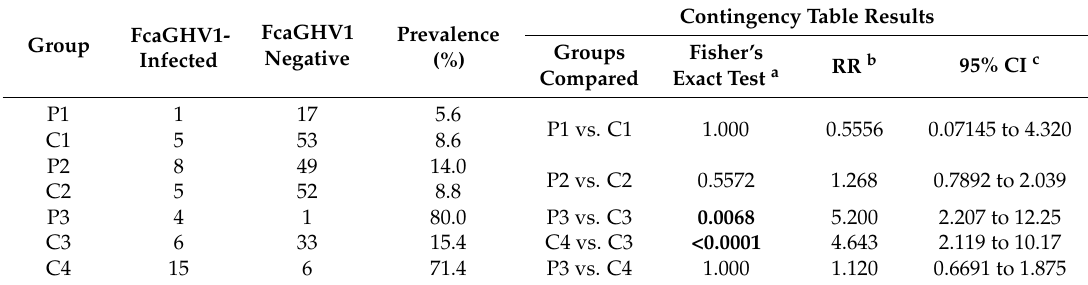
Table 2. Prevalence and analyses of FcaGHV1 DNAemia among patient and control